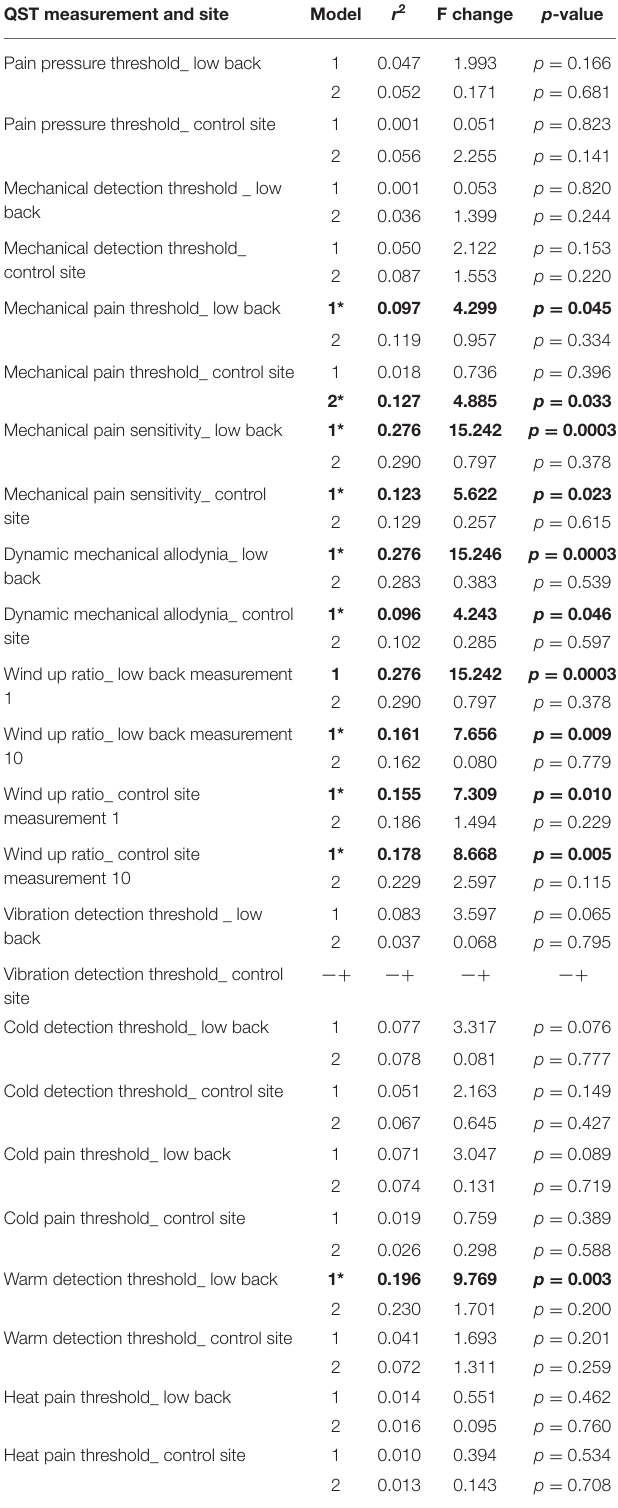
TABLE 9 | Stepwise linear regression of quantitative sensory testing QST with methylation (step 1) and IL2 (step 2). QST measurement and